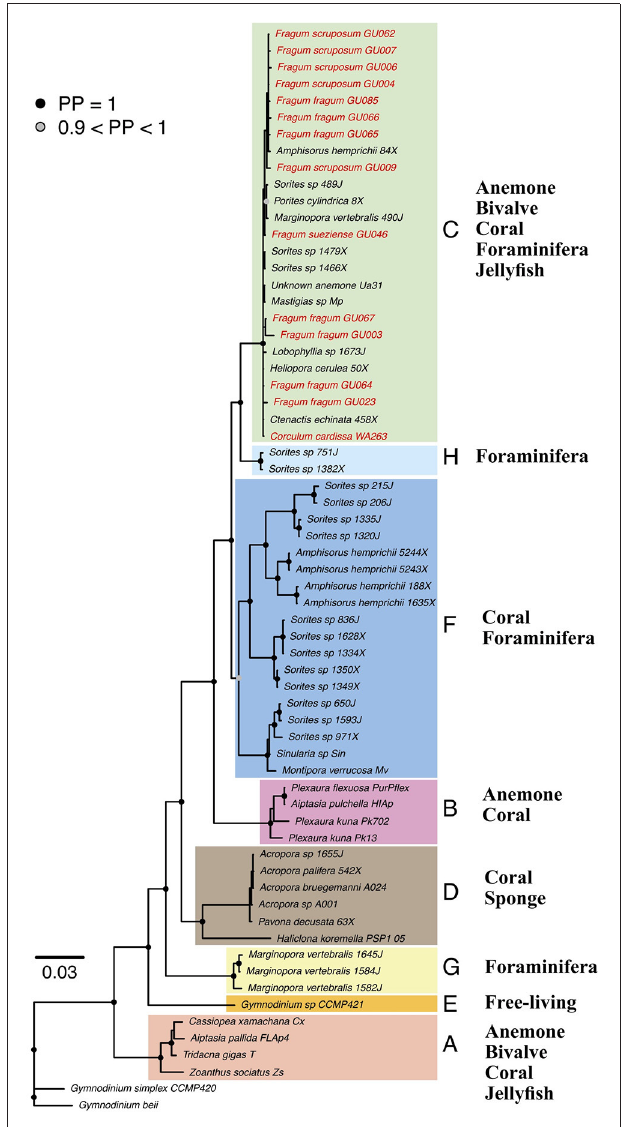
FIGURE 2 | Bayesian phylogeny of Symbiodinium from diverse invertebrate hosts based on concatenated gene dataset. Tip labels indicate host species and symbiont community ID. Node symbols represent posterior probabilities (PP), PP < 90% are not shown. Symbiodinium clades A–H are highlighted by color blocks. Fraginae Symbiodinium lineages are highlighted in red. General host groups are listed for each clade. Detailed concatenated and individual gene trees are deposited in TreeBase (ID: 21845).